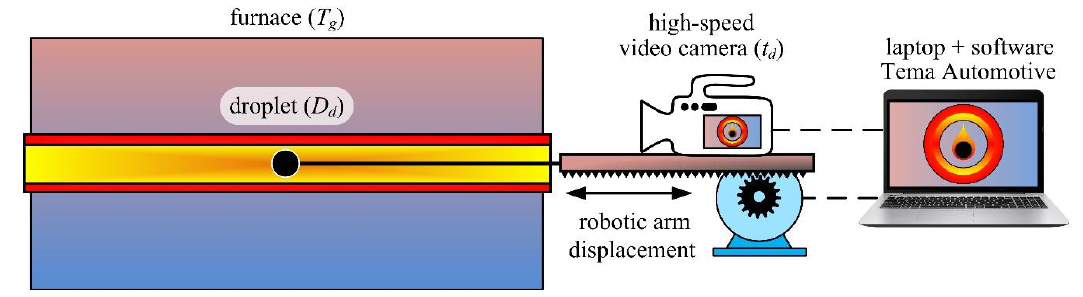
Figure 2. Scheme of experimental setup.